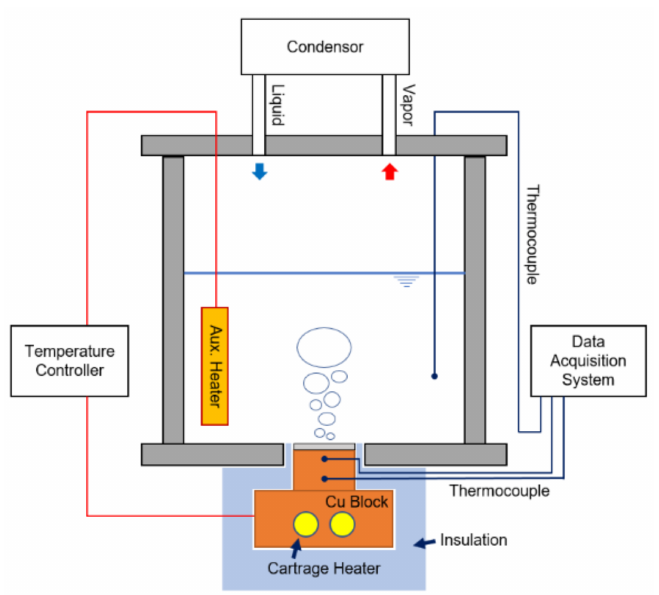
Figure 5. Schematic of experimental setup for boiling heat transfer using fabricated sample.